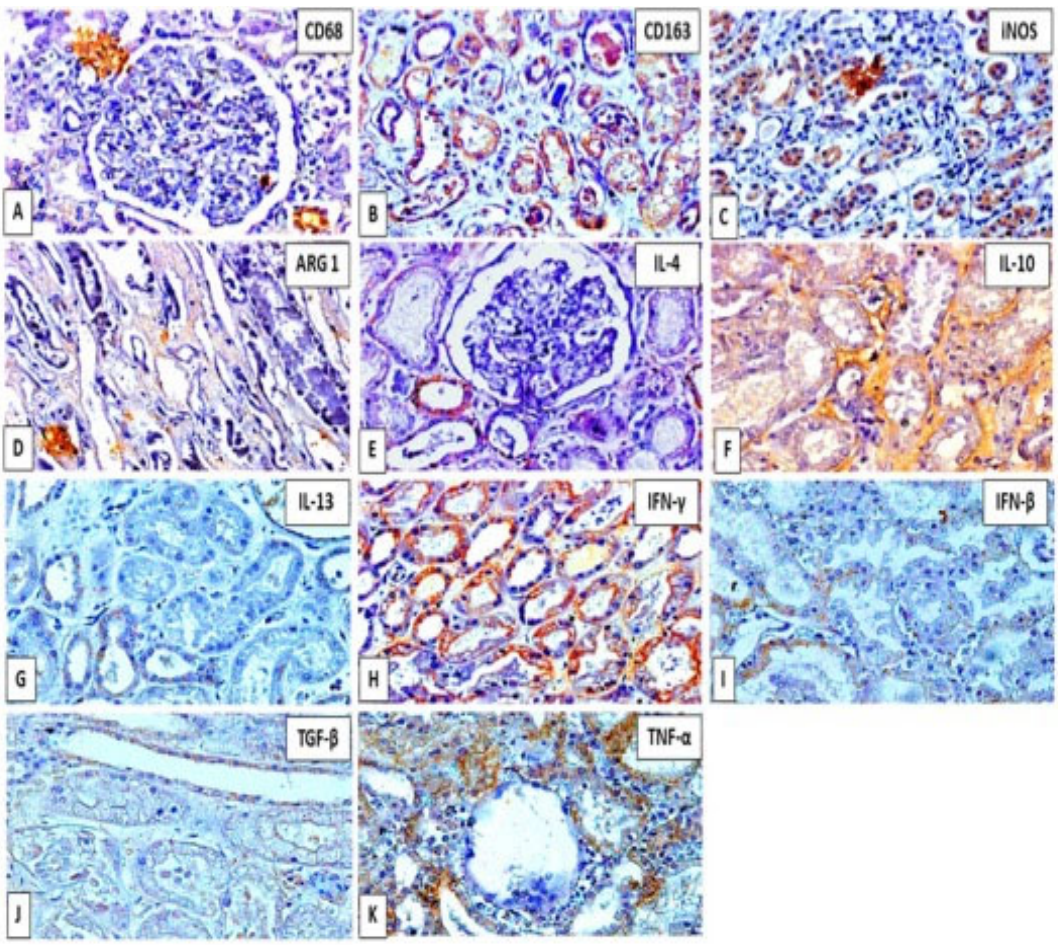
Figure 3. ( A – K ): Positive immunostaining pattern of factors that characterize the phenotype of M1 and M2 macrophages in the renal parenchyma of fatal yellow fever cases. ( A ) CD68 (mean = 28, median = 28, standard deviation = 17.26); ( B ) CD163 (39.45, 28, 24.60); ( C ) ARGINASE I (38.82, 30, 22.65); ( D ) iNOS (71.91, 80, 25.02); ( E ) IL ‐ 4 (31.55, 32, 8.96); ( F ) IL ‐ 13 (35.91, 35, 11.84); ( G ) IL ‐ 10 (40.36, 32, 31.25); ( H ) IFN ‐γ (37.18, 32, 21.13); ( I ) IFN ‐β (28.73, 28, 7.78); ( J ) TNF ‐α (52.09, 44, 20.85); ( K ) TGF ‐ β (25.45, 25, 3.857). Mann–Whitney ( p ≤ 0.05) *. Magnification